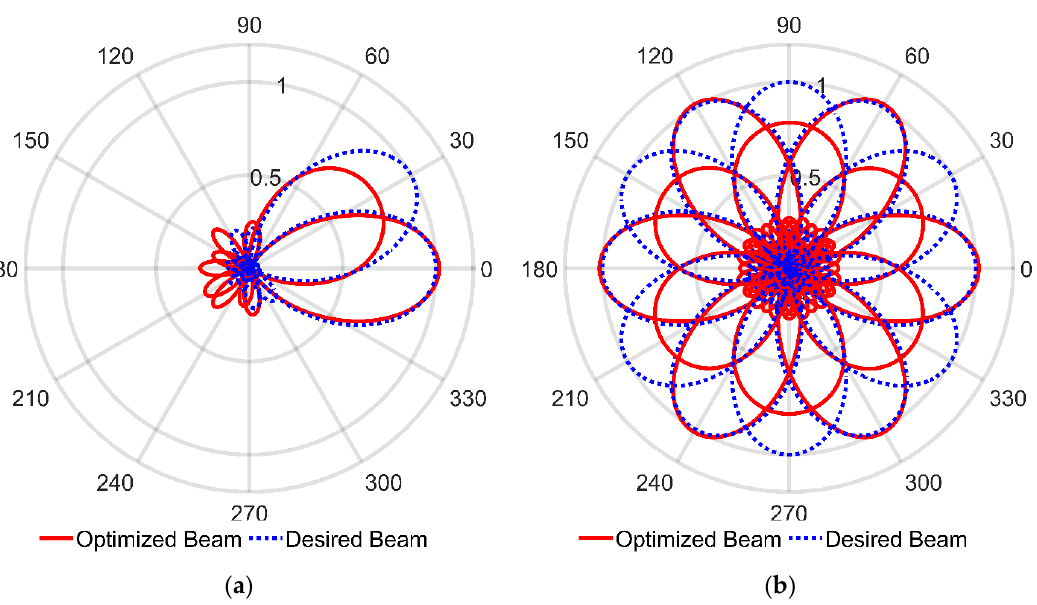
Figure 7. Beam Patterns of Regular Hexagonal Configuration: ( a ) Beam to 0° and 30°, ( b ) Rotated beams.